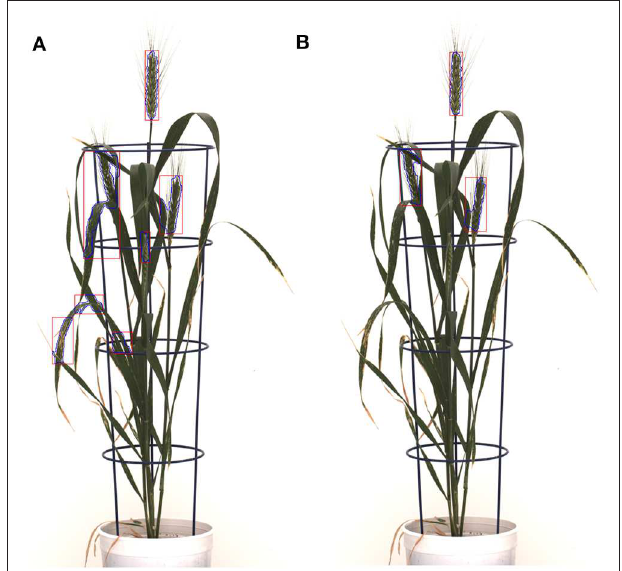
FIGURE 10 | The detected leaf artifacts in (A) result in a high spike area compared to (B) for the spike growth analysis. The segmented objects are represented with blue curves and red rectangular boxes; (A) the Qiongyan et al. method and (B) the proposed method.